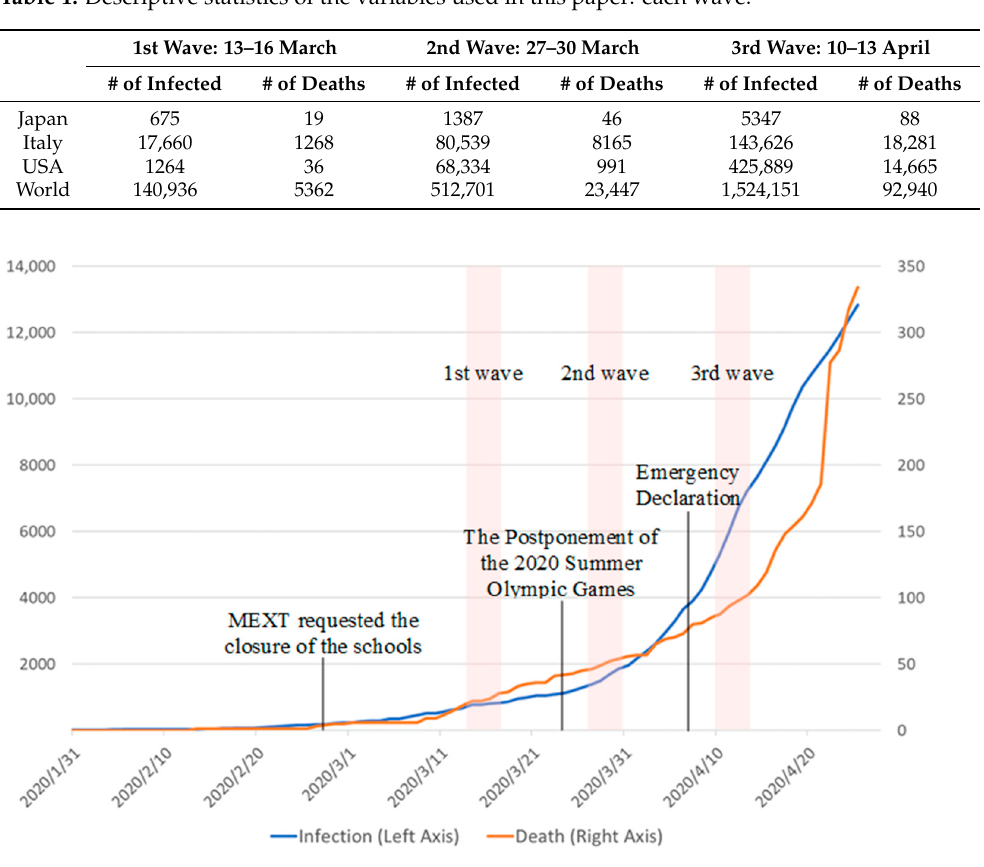
Figure 1. The number of the infected and the dead in Japan from 31 January to 26 April. Source: World Health